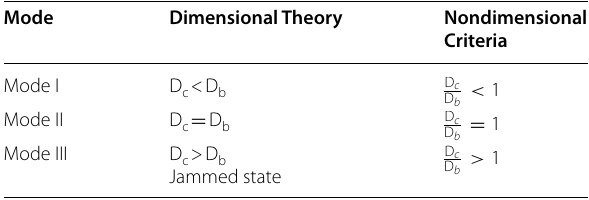
Table 1 Three ranges of the proposed model